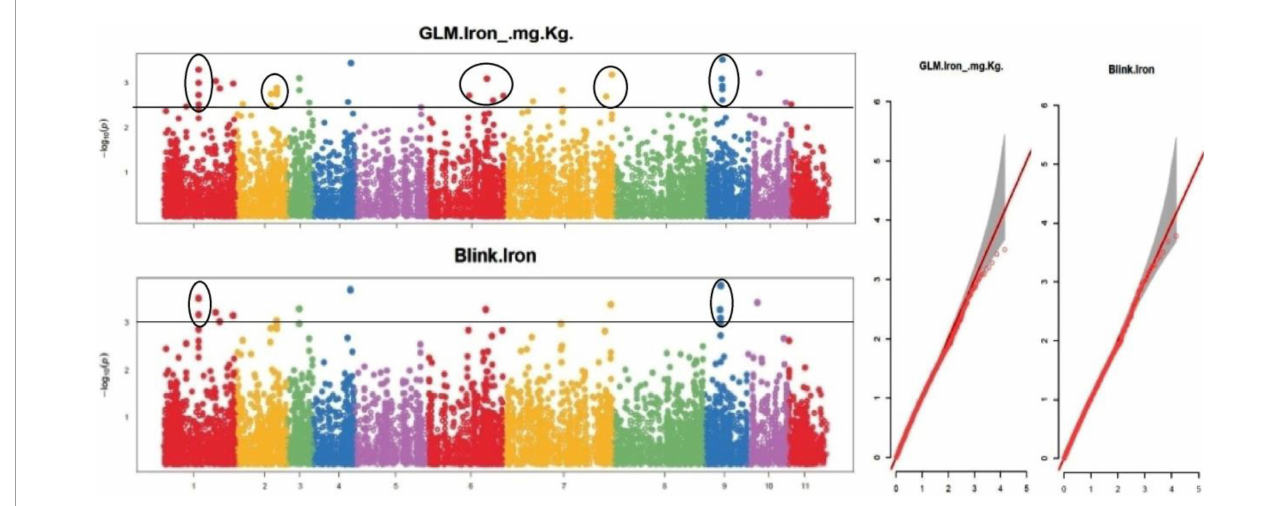
FIGURE6 Manhattan plots and Quantile-Quantile plots depicting the significant association of SNP markers with grain iron concentration.